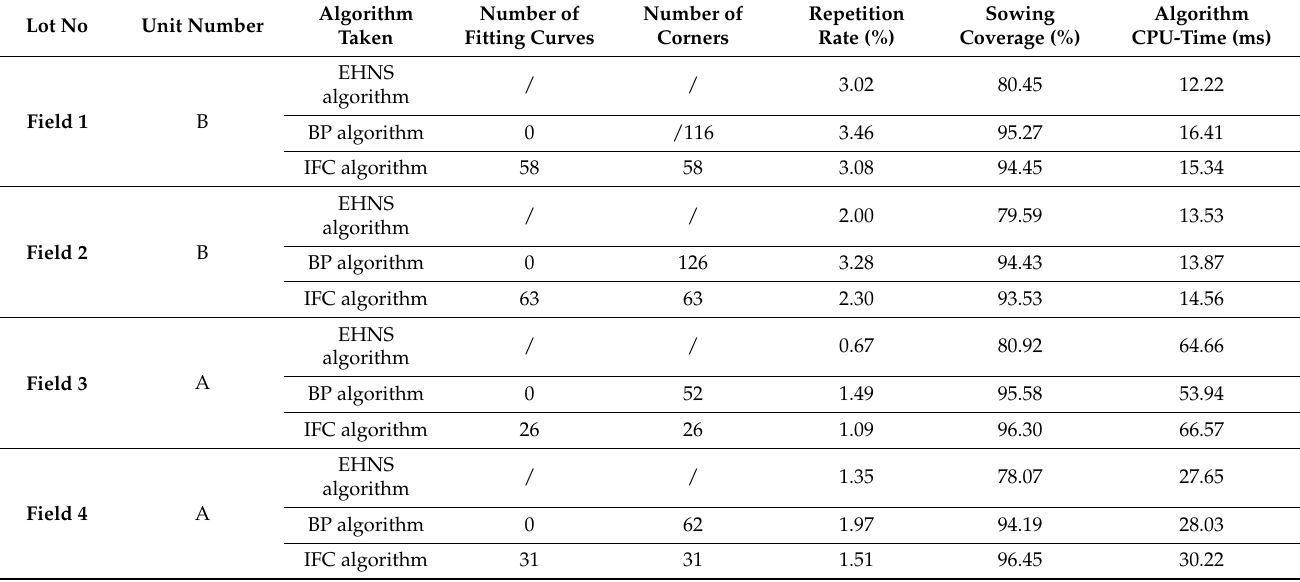
Table 3. Irregular field path planning algorithm test